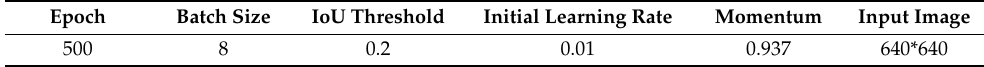
Table 4. Training parameter settings of YOLOv5 and YOLOv7.